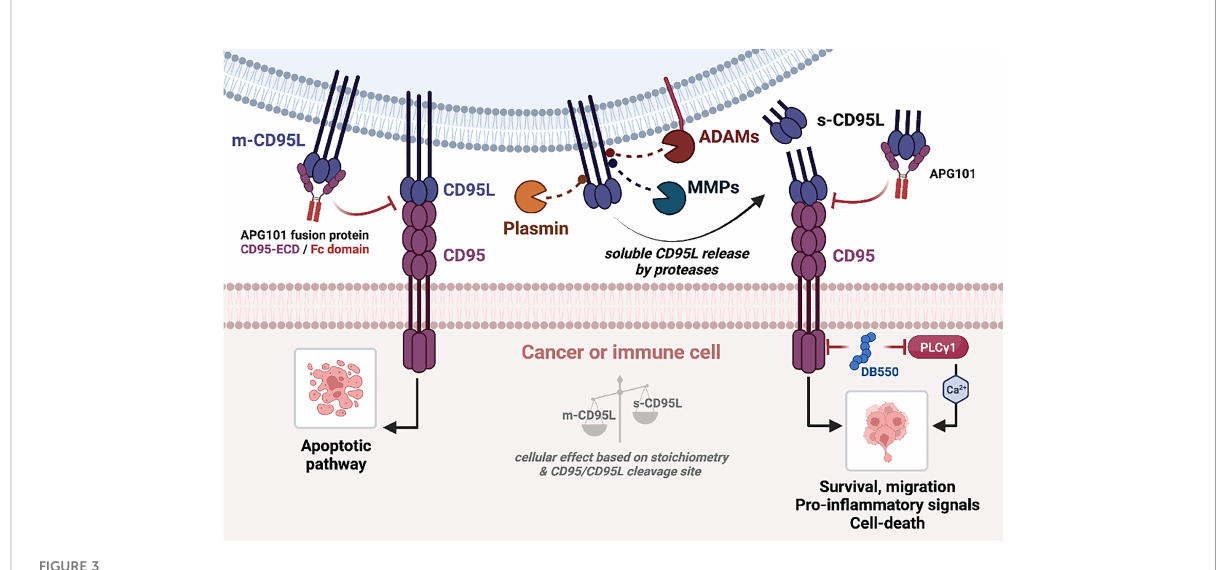
FIGURE 3 CD95/CD95L-mediated signaling pathways. (Left) Binding of m-CD95L to CD95 induces an apoptotic signaling pathway. (Right) m-CD95L processing by proteases (ADAMs, MMPs, plasmin) leads to the release of different s-CD95L in the extracellular environment. Depending on the ratio m-CD95L/s-CD95L, and the shedding sequence, several signaling pathways can be triggered: cell survival, migration (promotes the development of metastases), chemoattraction and pro-in fl ammatory signal, or cell death. Blocking of CD95L binding to CD95 by APG101 (Asunercept) blocks both apoptotic and non-apoptotic signaling